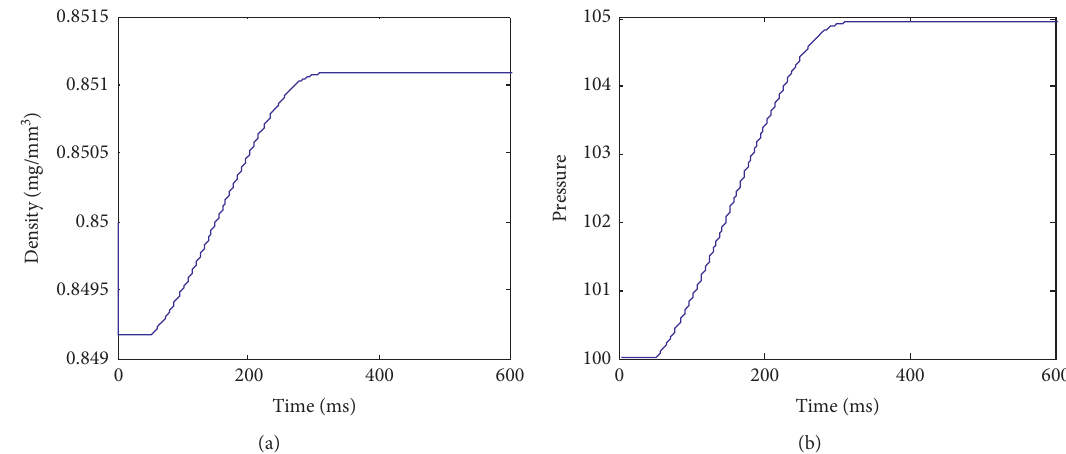
Figure 7: Changes in fuel pressure and density in the high-pressure fuel line with